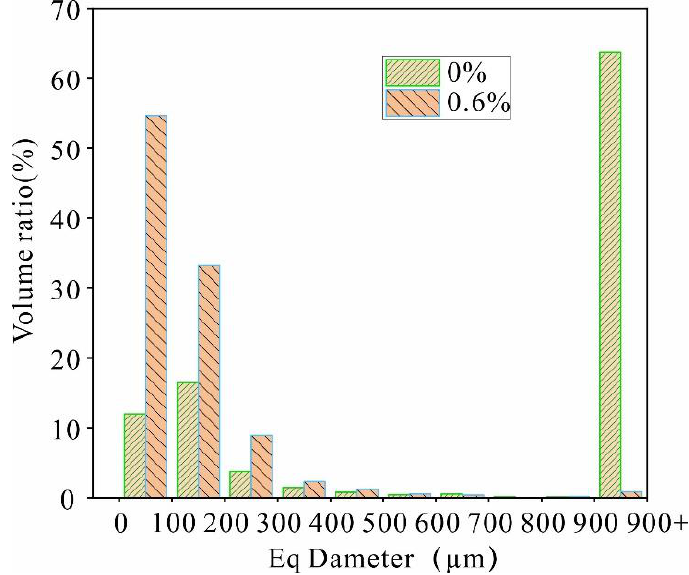
Polymers 2022 , 14 , x FOR PEER REVIEW Figure 19. Frequency distribution of the Eq diameter. Figure 19. Frequency distribution of the Eq diameter.